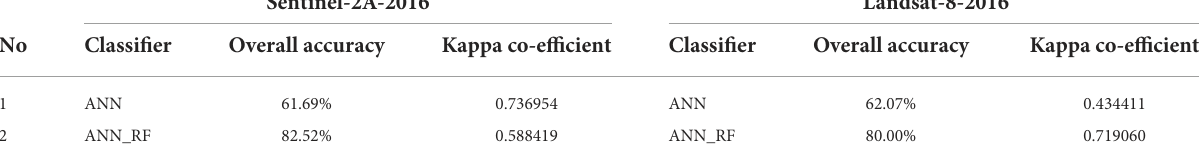
TABLE 3 Overall accuracy and Kappa coefficient for ANN and proposed work